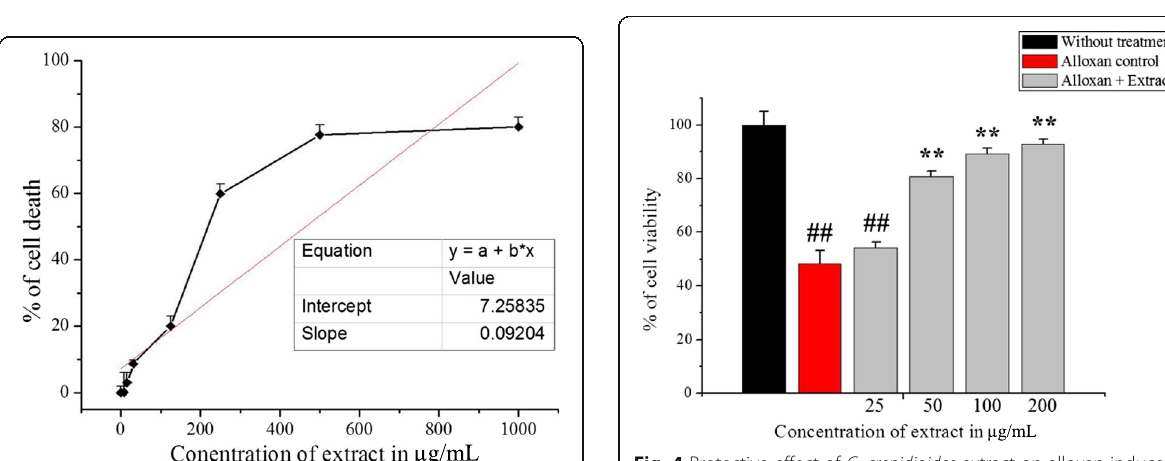
value (100%, p < 0.01), respectively.